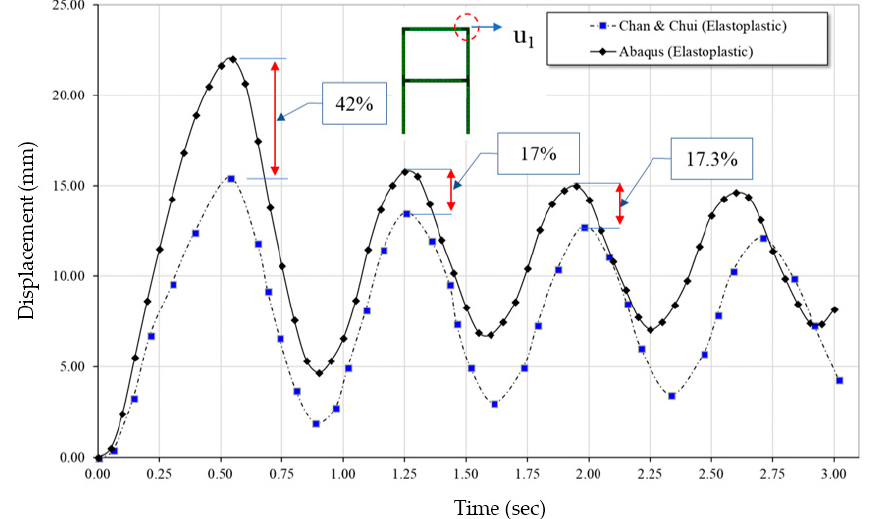
Figure 16. Elastoplastic analysis dynamic response ABAQUS and Chan and Chui [15].